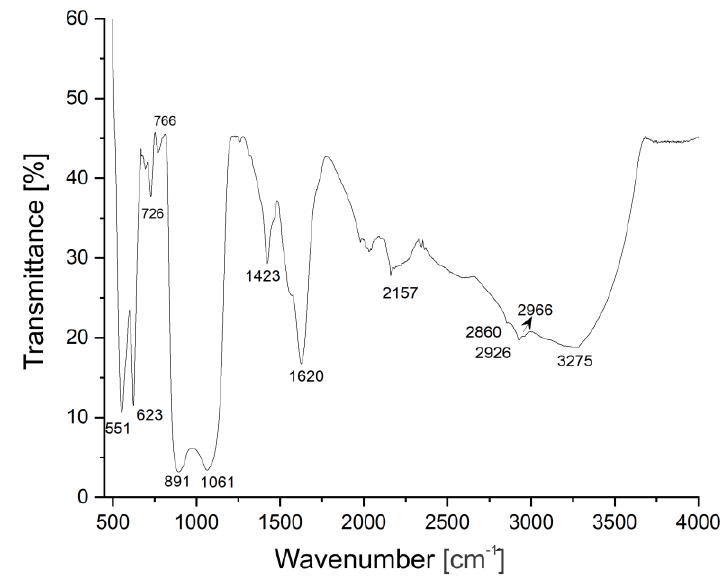
Figure 7. FTIR spectrum of DIO-NPs